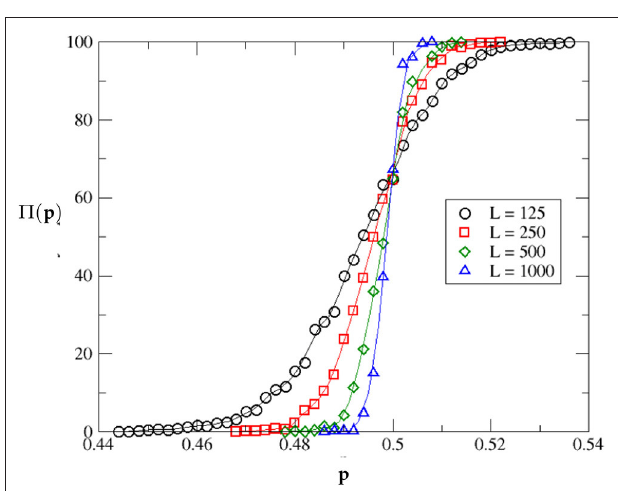
FIGURE 6 | A plot showing the percentage percolation probability 5 for different values of site occupation probability p , as obtained from our simulations. Results were averaged over 500 iterations for each system size L . The running average method was used to approximate the data points and estimate the critical percolation probability, which turns out to be 0.499 when diagonal connection probability q is